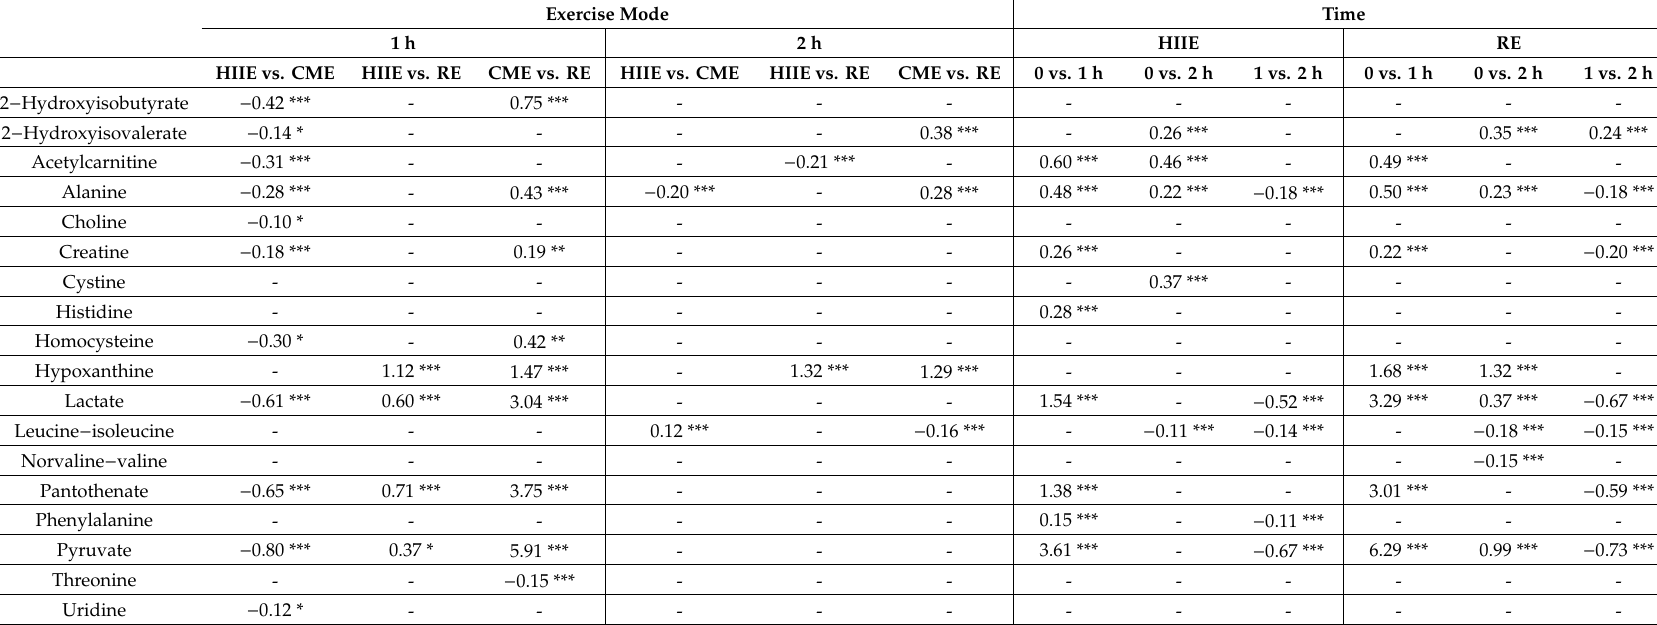
Table 1. Important serum metabolites that explain the valid PLS-DA